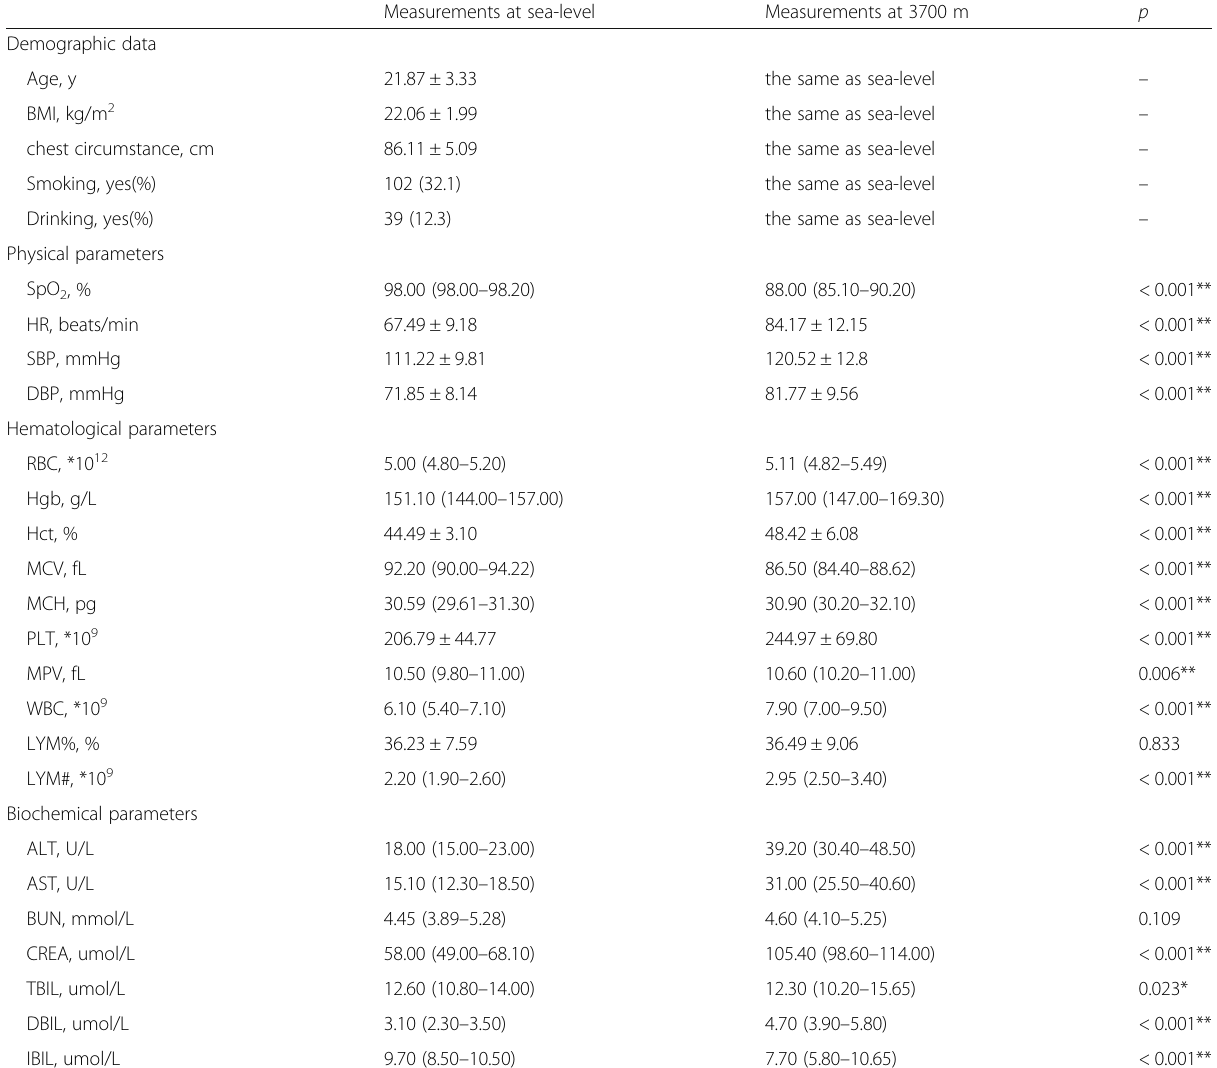
Table 1 Comparison of physiological, hematological and biochemical parameters between sea level and 3700 m ( N = 318) Measurements at